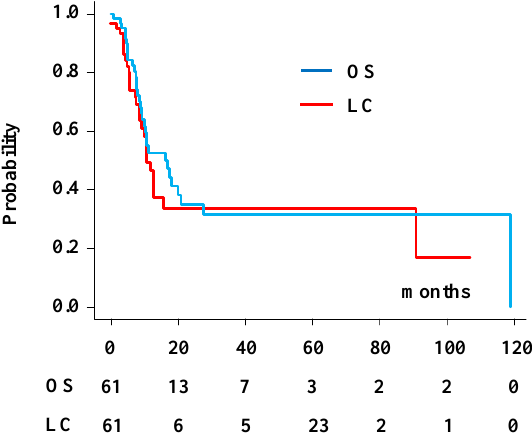
Figure 3. Local control and overall survival rate after reirradiation for squamous cell carcinoma of the nasal cavity or paranasal sinus.